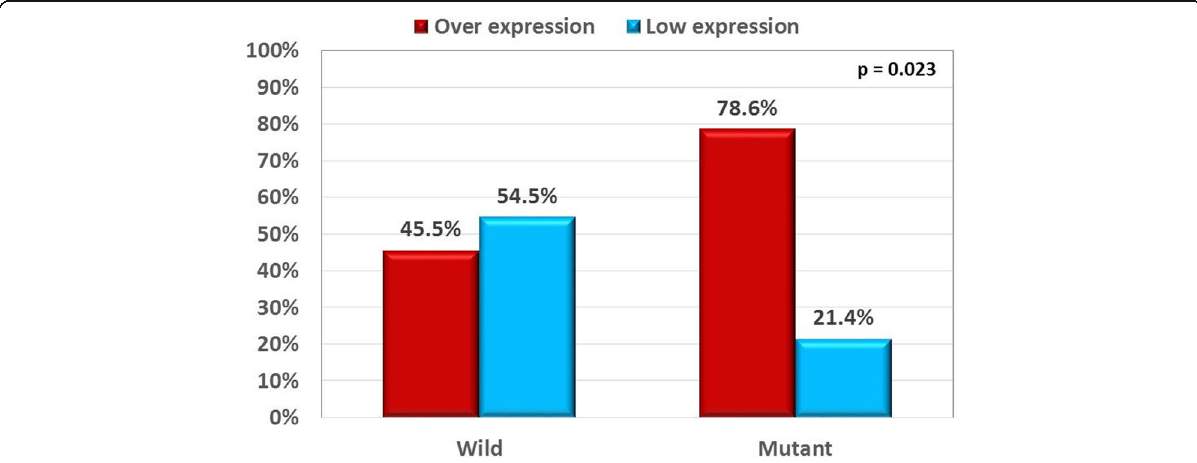
Fig. 2 Comparison of expression (high, low) of RUNX1 in wild and mutant FLT3